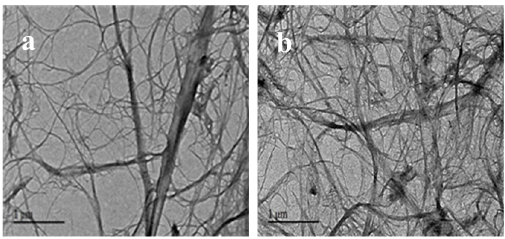
Figure 2. Transmission electron microscopy (TEM) images of ( a ) nanofibrillated cellulose (NFC) and ( b ) acetylated nanofibrillated cellulose (ANFC).